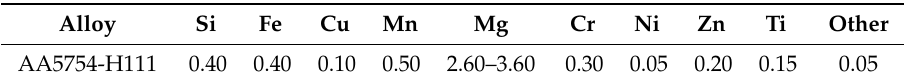
Table 1. Chemical composition of the 5754-H111 aluminum alloy.